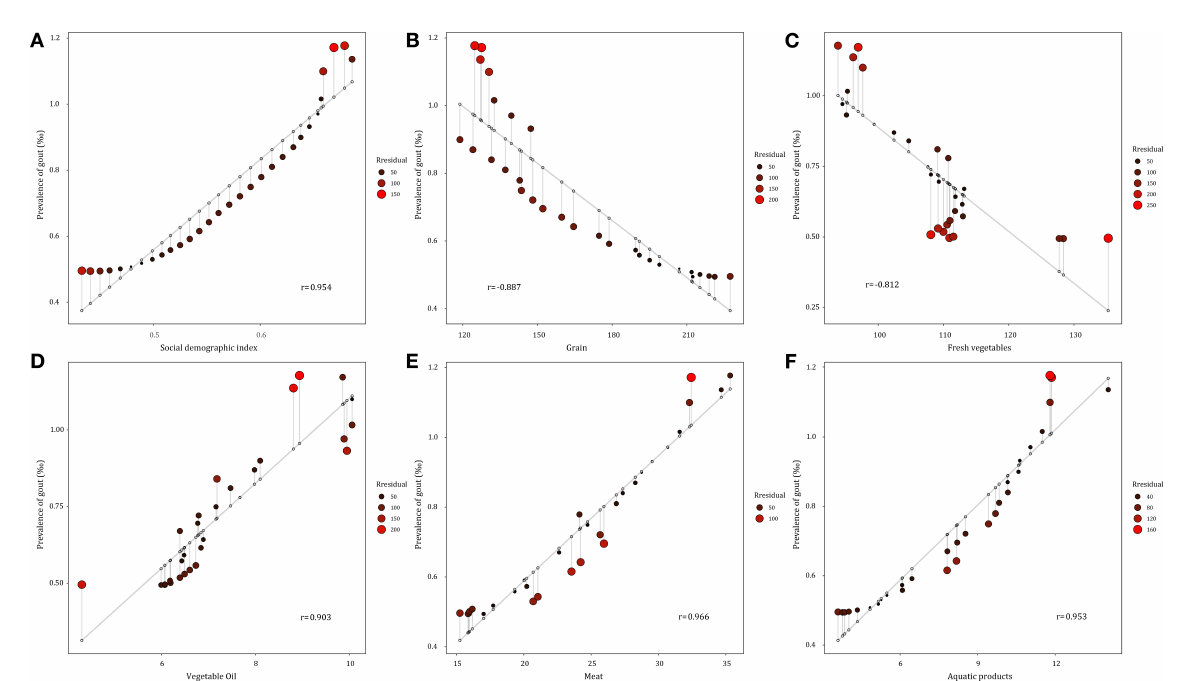
FIGURE4 Correlation between gout prevalence and social demographic index and major food consumption from 1990 to 2019 in China. (A) Social demographic index. (B) Grain consumption. (C) Fresh vegetable consumption. (D) Vegetable oil consumption. (E) Meat consumption. (F) Aquatic products